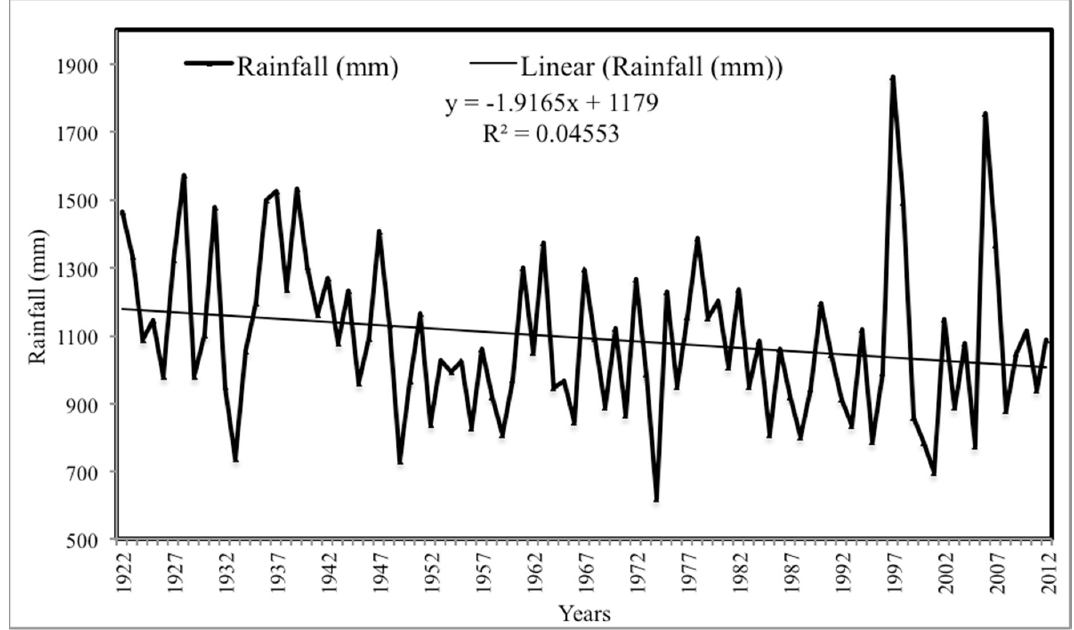
Figure 3. Lushoto long-term annual rainfall trend (1922–2012).